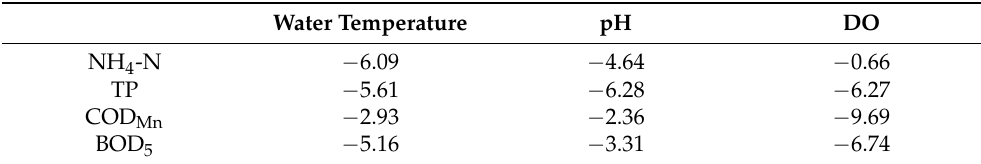
Table 4. The average contribution rate of different environmental factors to water quality indica- tors (%).